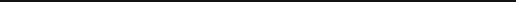
General and savings taxable incomes are then taxed according to different tax schedules. The tax schedules are split into a state and a region portion, since around half of the tax revenue is transferred to the regions, which are entitled to design their tax schedules and introduce their own tax benefits. 13 In 2015, the state general tax schedule consisted of 5 tax brackets and a top marginal rate of 22.5%. The regional general tax schedule, which is applied on top of the state one, varies across regions. For example, the tax schedule in Catalonia (the largest Spanish region in terms of GDP in 2015) consisted of 6 tax brackets and a top marginal tax rate of 25.5%, whereas that of the Community of Madrid (the second largest region) has 5 tax brackets and a top marginal rate of 21.0%. Therefore, taxpayers in Catalonia faced a top marginal rate of 48% (22.5% + 25.5%), while Madrid taxpayers were subject to a top marginal rate of 43.5% (22.5% + 21.0%). The savings tax schedule is much less progressive. In 2015, the state portion consisted of 3 brackets and a top marginal rate of 11.5%, whereas the region portion, which did not differ across regions, comprised 3 brackets and a top rate of 12.0%. Figure 2 shows the tax schedules in the two selected regions in